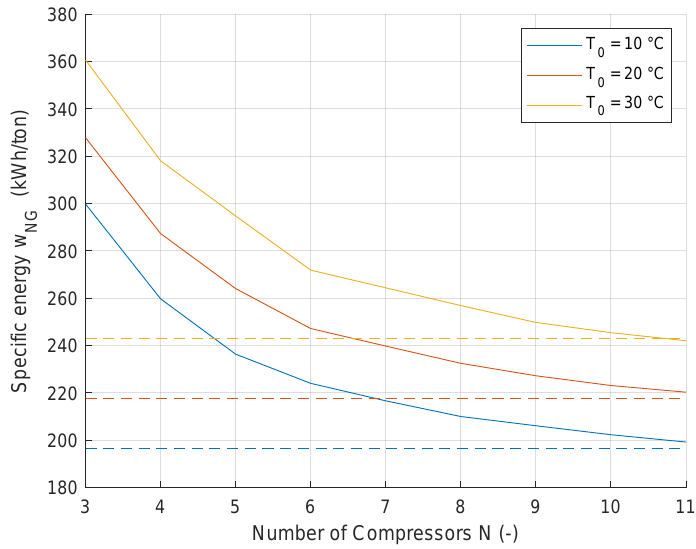
Figure 8. Variation of the specific energy consumption of optimized process with N compressor stages and ambient seawater temperature T 0 . Dashed lines are mixed fluid cascade (MFC)